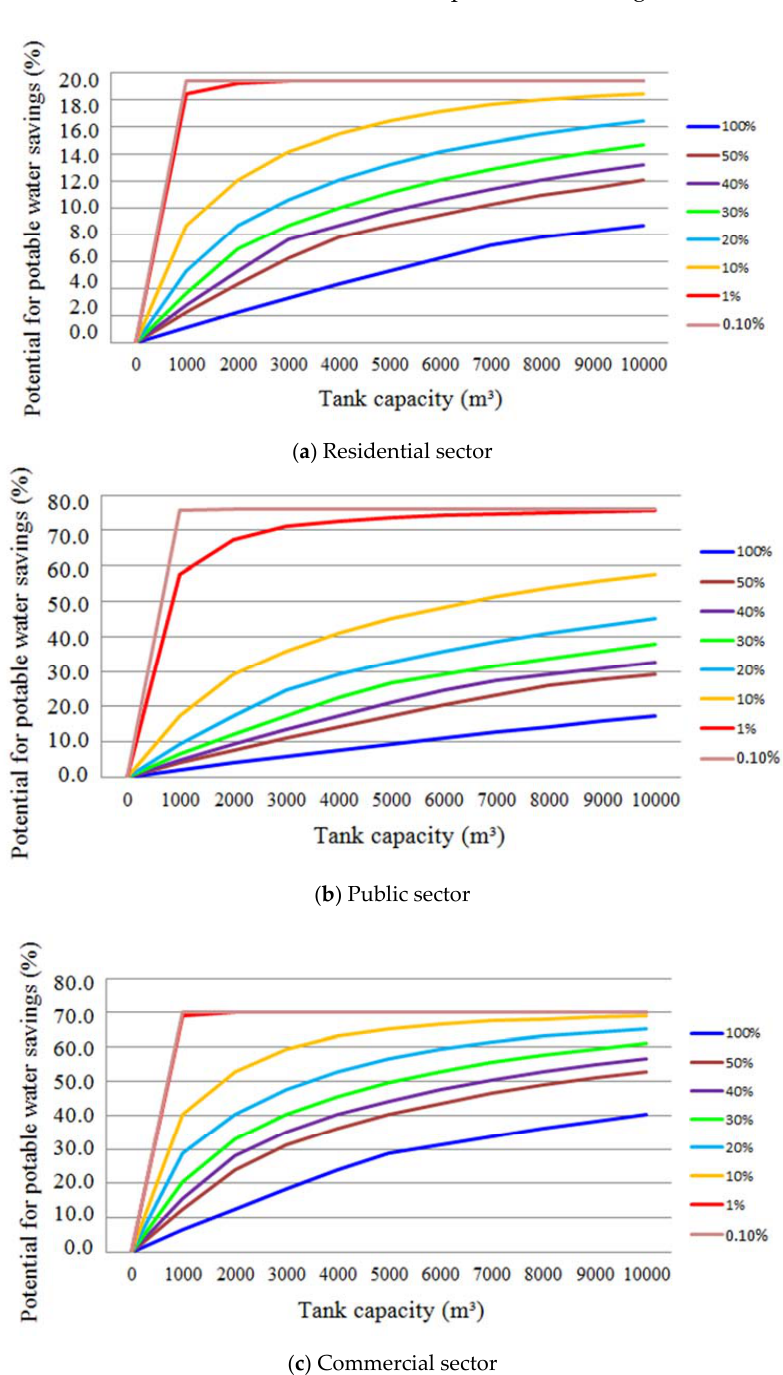
Figure 6. Potential for potable water savings for different tank capacities and different paved road surface areas for each sector. ( a ) Residential sector; ( b ) Public sector; ( c ) Commercial